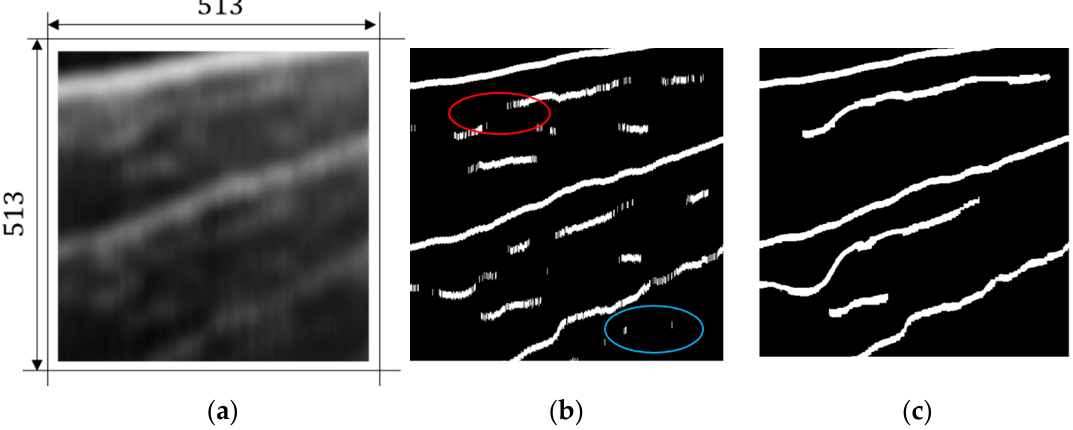
Figure 4. Human-computer interaction. ( a ) An input. ( b ) The corresponding tile to the input tile after automatic horizons extraction. The white pixels are extracted horizons. ( c ) A label. The tile after artificial recovery. The label is the corresponding binary tile in which the pixel values of horizons are 1, and the others are 0. The width of the horizon is 10 pixels. The noise in ( b ) is removed manually, such as the white part in the blue ellipse. The obvious discontinuities of horizons are connected manually, such as the discontinuity in the red ellipse.